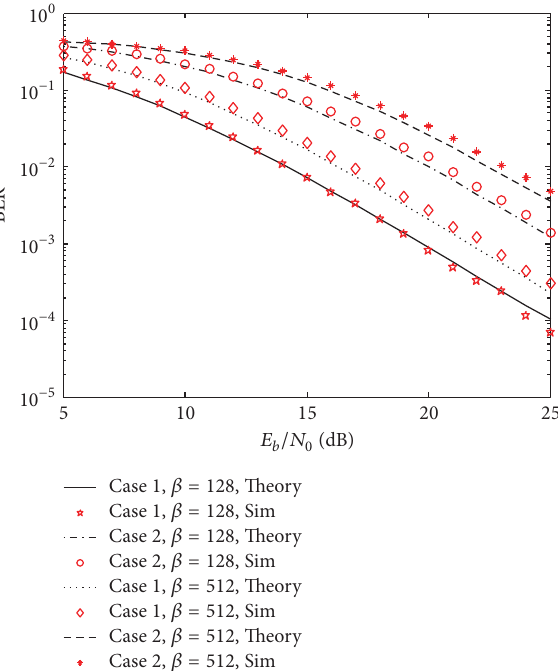
Figure 10: Relationships between analytical BER and Monte Carlo results in Rayleigh fading